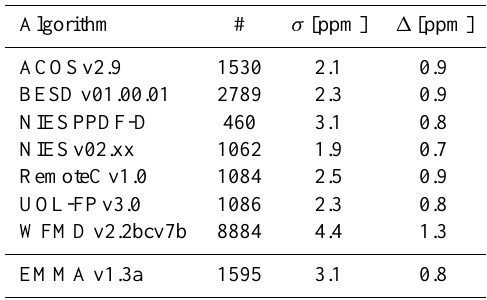
Table 2. Validation statistics (June 2009–May 2010) for all TC- CON sites with more than ten co-locations (Białystok, Poland; Dar- win, Australia; Garmisch-Partenkirchen, Germany; Lamont, USA; Orl´eans, France; Park Falls, USA; Wollongong, Australia) with number of co-locations (#), average single measurement precision ( σ ), and standard deviation of station-to-station biases ( 1